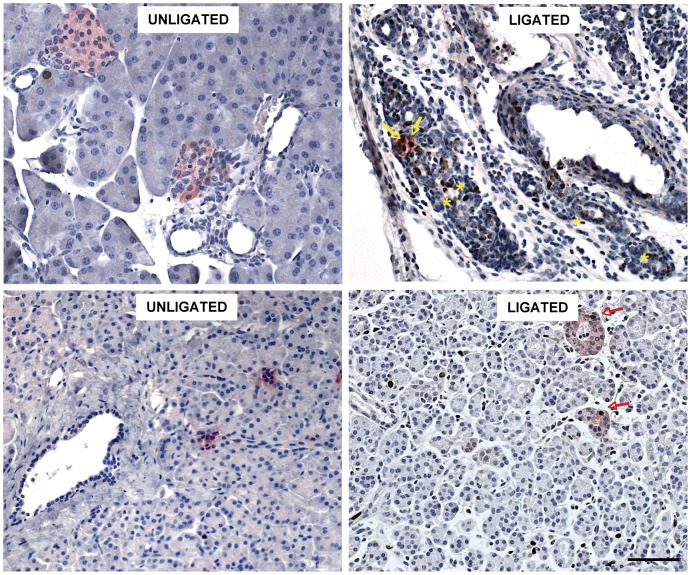
Proliferation-activated beta cells in small beta cell clusters of PDL-mouse tails (left panel) and of human pancreas with inflammatory infiltration (right panel).Two weeks after PDL pancreatic tails contain a larger pool of Ki67-positive beta cells in the small beta cell clusters (arrows in left panel) (391±84 cells versus 27±27 in unligated tails, p<0,01). They also present higher percentages of Ki67-positive cells in large and small ducts (arrowheads). A number of human donor organs were found to present a diffuse inflammatory infiltration [14]. The small beta cell clusters in three consecutively analysed organs contained higher percentages of Ki67-positive beta cells (arrows in right panel) than those in age- and gender-matched controls without infiltration (3, 0.8 and 1.4% versus ≤0.1%). Immunohistochemistry for insulin (red) and Ki67 (brown), scale bar 100 µm.